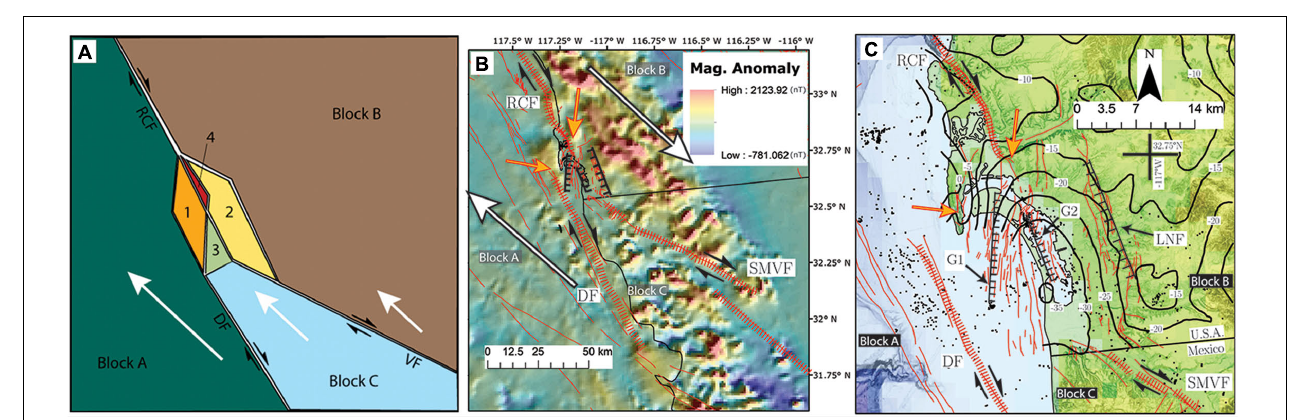
FIGURE 15 | (A) Conceptual kinematic block model for the San Diego region. See section “DISCUSSION” for full model explanation. Block A, B, and C are separated by master strike-slip segments (RCF, DF, and VF) with a region of complex faulting located at their intersection beneath San Diego Bay. (B) Magnetic anomaly data of North America (Bankey et al., 2002). Master strike-slip faults in conceptual block model, particularly the San Miguel-Vallecitos fault, appear to correlate with regional low magnetic anomalies in the otherwise continuous magnetic high associated with the Peninsular Range Batholith. This may be an indication that these faults follow pre-existing weaknesses or delineate terrane boundaries that are responding to the regional strain field. (C) Map of San Diego Bay showing gravity contours from Marshall (1989). Gravity contours (solid black lines) are in mGal and show a potential gravity low in south San Diego Bay. Fault traces (thin red lines) are from USGS (2019) north of the United States-Mexico border and Fletcher et al. (2014) south of the border. Master strike-slip segments are RCF, Rose Canyon fault, DF, Descanso fault, VF, Vallecitos fault, SMVF, San Miguel-Vallecitos fault. Background topography and bathymeter are from ESRI topography and the National Centers for Environmental Information Southern California Coastal Relief Model (v2) (Calsbeek et al., 2013).